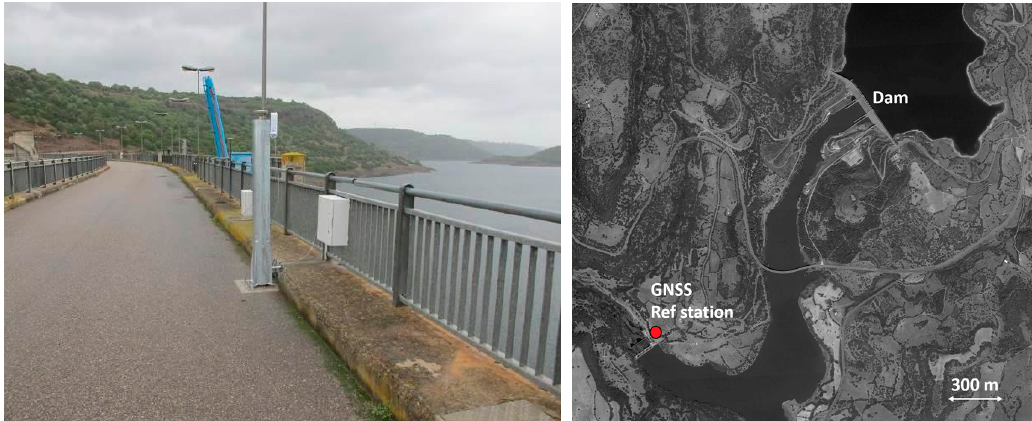
Figure 3. One of the GNSS antenna monitoring the dam and the position of the reference station.